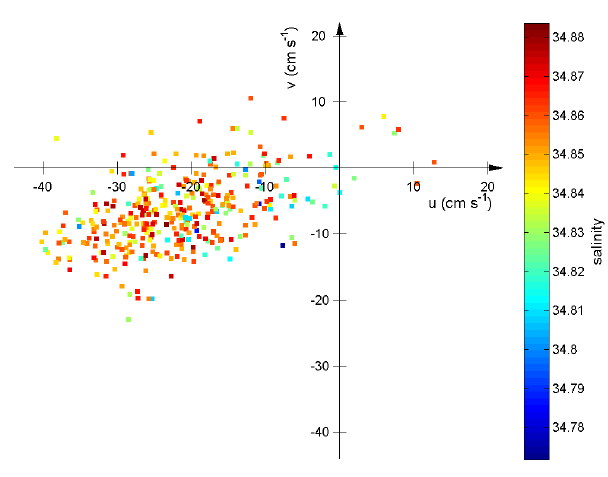
Fig. 4. Scatterplot of UK1 current meter velocity eastward (u) and northward (v) components coloured by UK1 salinity for the period August 1998 to December 2004. Data have been binned into 5-day means and tidal signals have been removed.